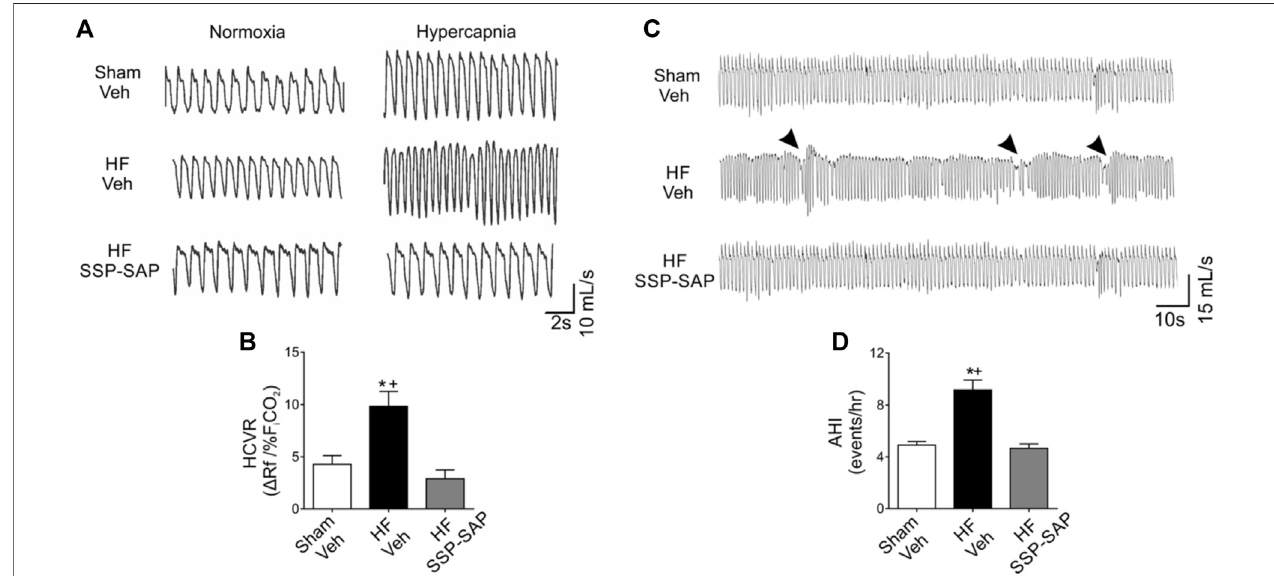
FIGURE 2 | Partial ablation of RTN neurons blunts the hypercapnic ventilatory response and decreases incidence of breathing disorders in HFpEF rats. (A) Representative traces of ventilation during normoxia (F i CO 2 0.03%), and hypercapnia (F i CO 2 7%) in one rat per group. (B) Summary data of hypercapnic ventilatory response(HCVR).Note that theincreased HCVR in HF ratsis abrogated by partial ablation of RTNneurons using substance P-conjugatedsaporin (SSP-SAP) toxin. (C) Representative traces of ventilation in normoxia at rest. Arrows depict breathing disturbances (i.e., apneas/hypopneas). (D) Partial ablation of RTN neurons decreases the apnea/hypopnea index (AHI) in HF rats. Modi fi ed from Am J Physiol Lung Cell Mol Physiol. 318: L27 – L40,